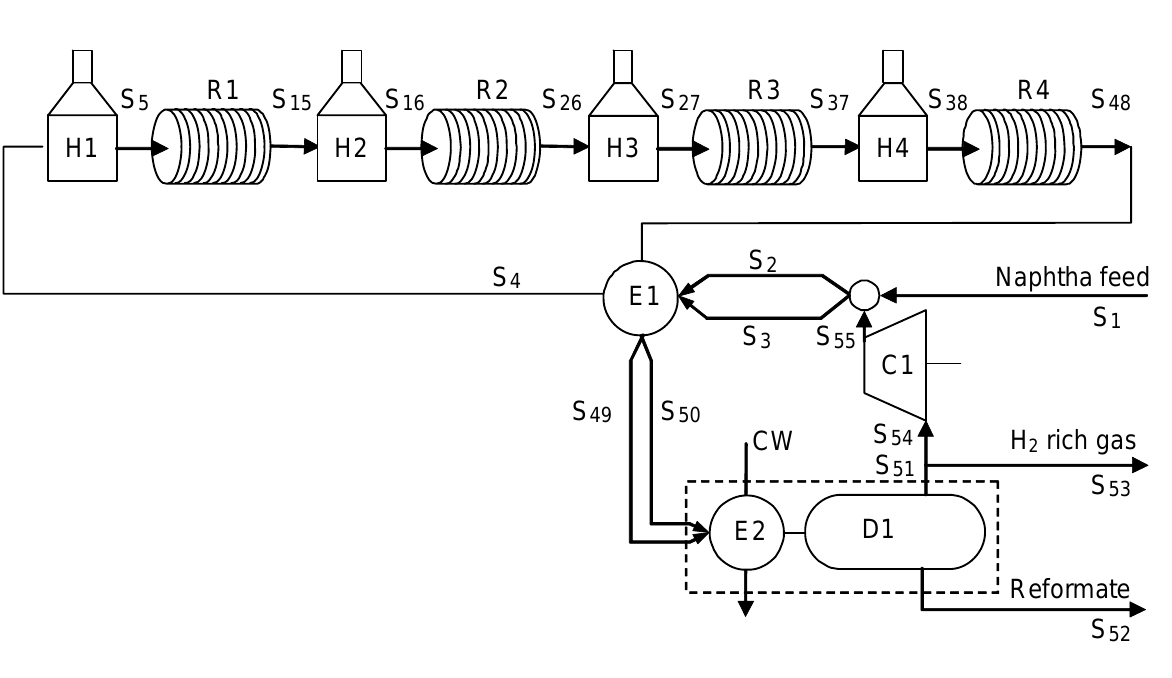
Figure 2: Model structure of naphtha